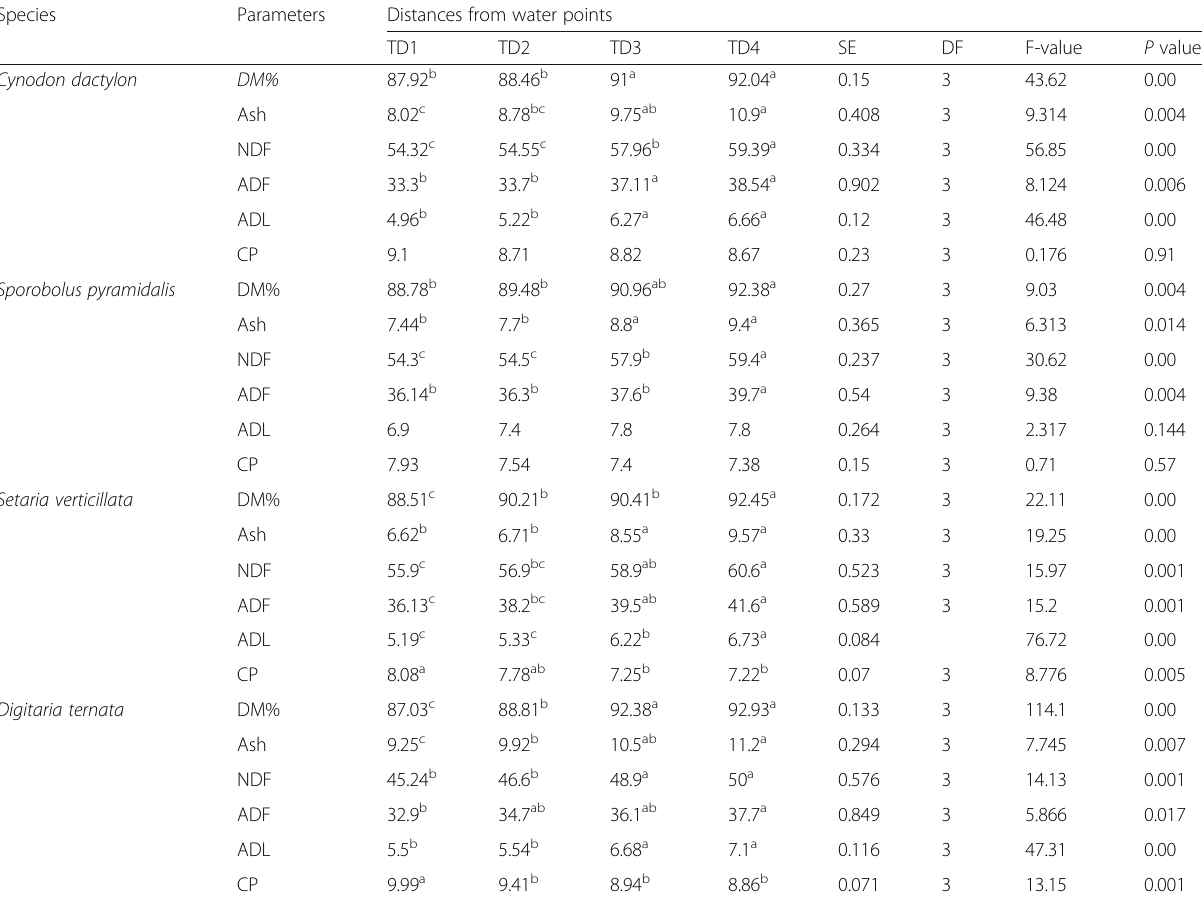
Table 5 Effects of grazing intensity on chemical compositions of major grass species in Chagni ranch, Northwest Ethiopia Species Parameters